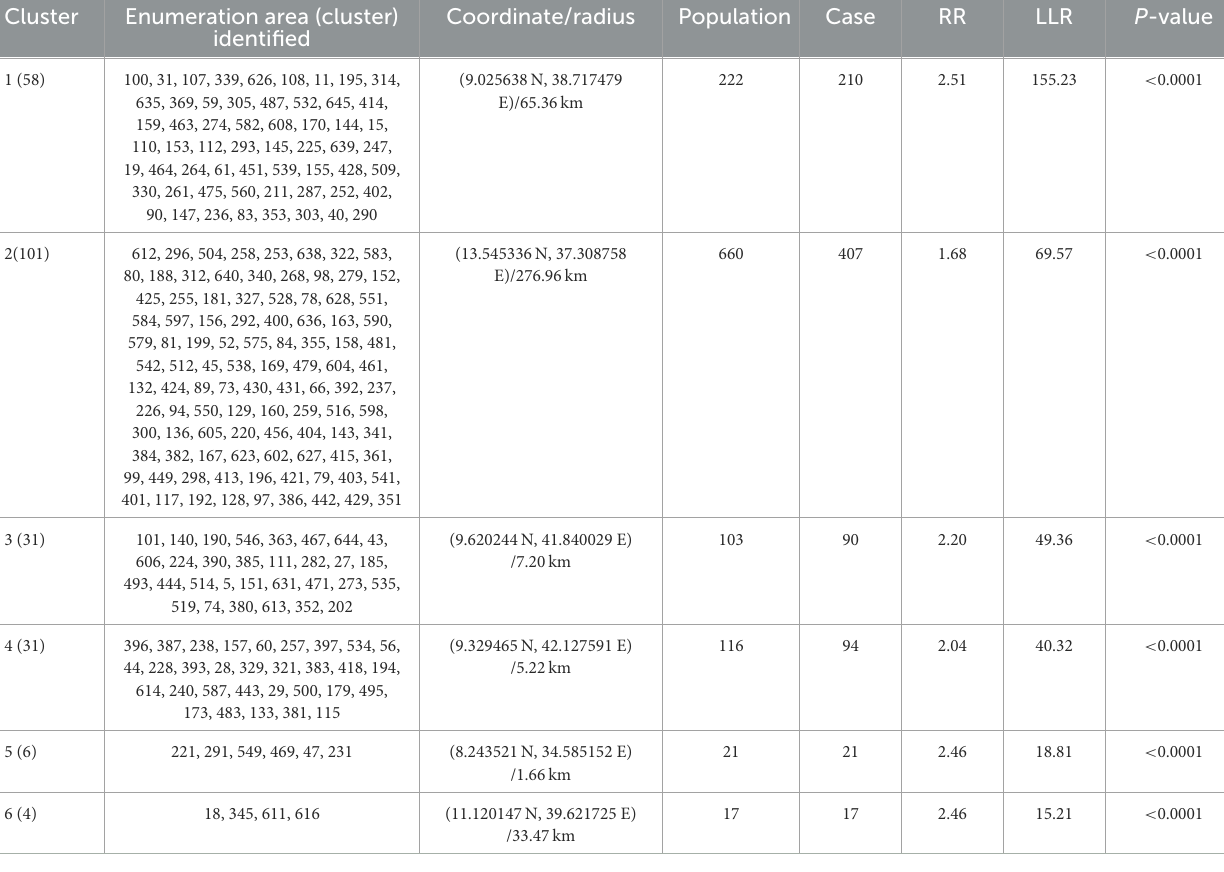
TABLE 2 SaTScan analysis result of prenatal HIV test uptake in Ethiopia based on the 2016 EDHS. Cluster Enumeration area (cluster) Coordinate/radius Population Case RR LLR P -value identified